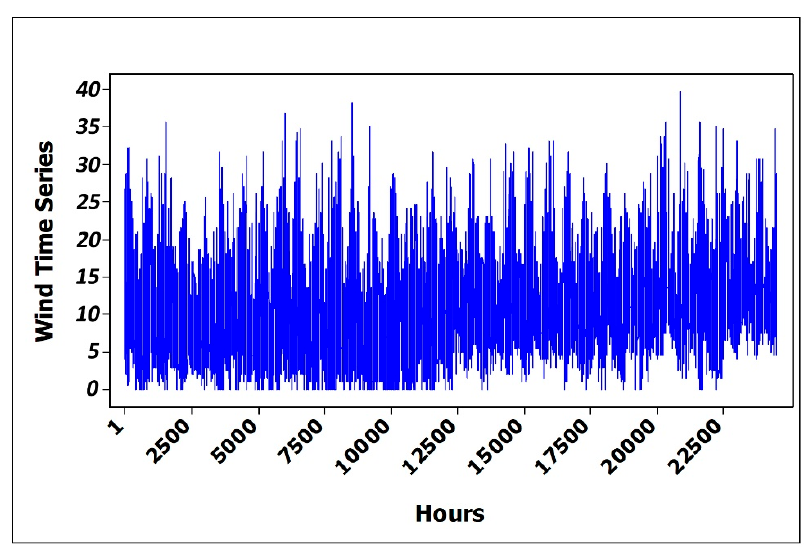
Figure 5. Wind speed (km/h) time series fluctuations in the current study.